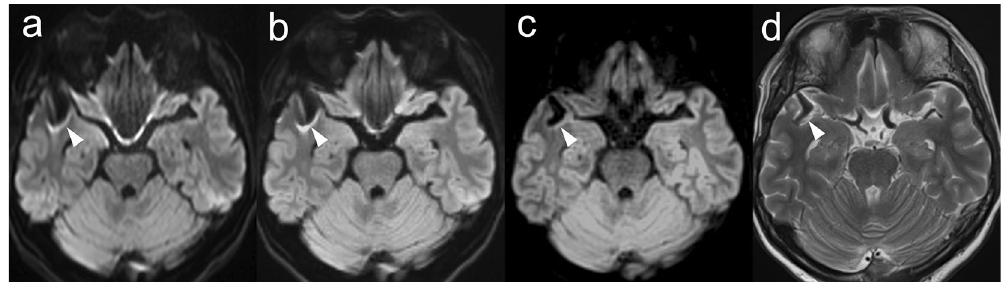
Figure 3. Representative images of SS-EPI DWI ( a ), RESOLVE DWI ( b ), TGSE-BLADE DWI ( c ) and T2WI ( d ) in a 60-year-old female patient after cerebral aneurysm clipping at the right middle cerebral artery. The arrowheads indicate the clip and the clip-induced artifacts. TGSE-BLADE DWI has the least artifact and distortion.